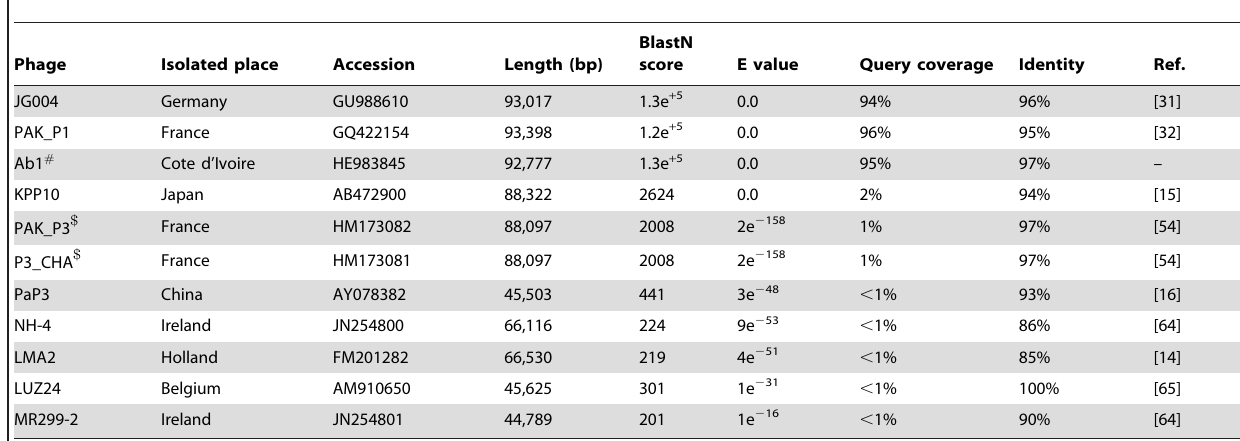
Table 5. Comparison of phages with BlastN scores of more than 200 against the PaP1 genome.